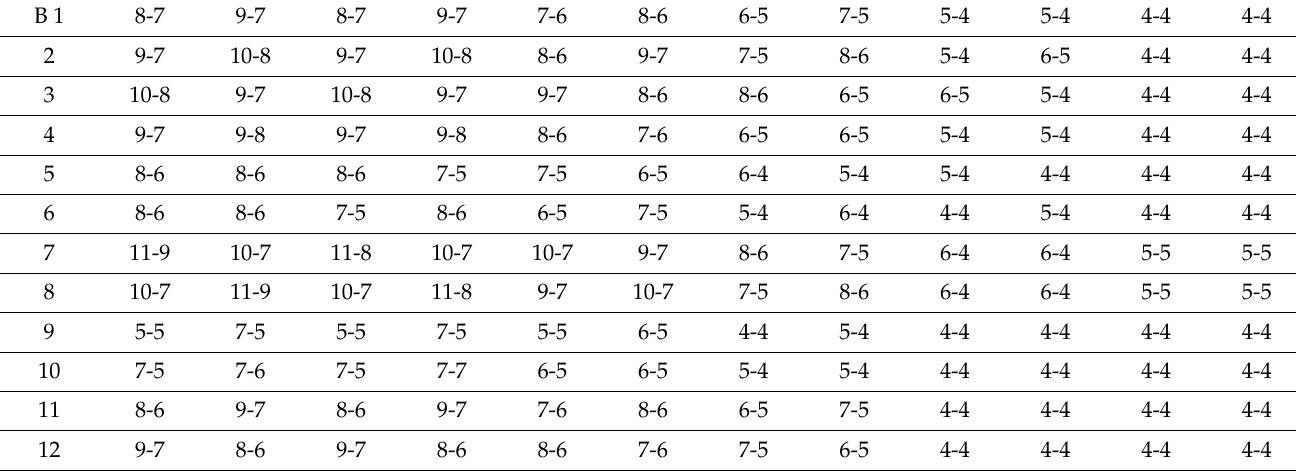
Table A3. Longitudinal reinforcement details of beams of the six-story building. All beams have steel bars of 16mm diameter, and the number of bars is reported at the upper and lower fibers of the end-sections, at the start ( s ) and at the end ( e ) of beams (e.g., s 8-7 means 8Ø16 at the upper fiber and 7Ø16 at the lower fiber of the start section of the beam).